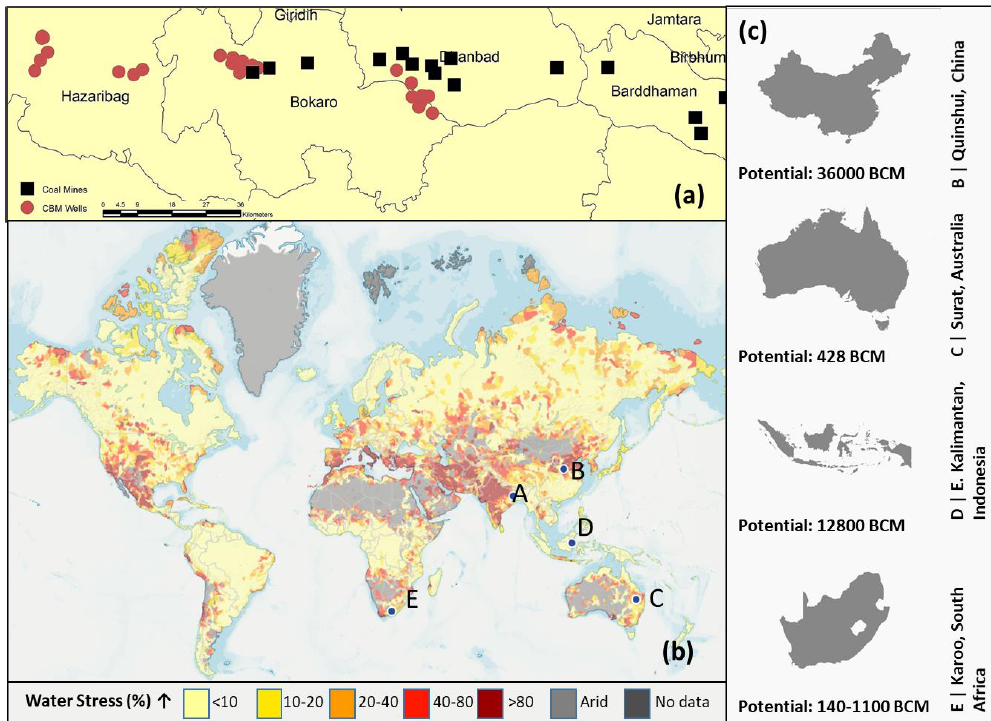
Figure 5. ( a ) Our case study region in the Damodar Valley coalfields in India shows not only the possibility of a large amount of CBM-produced waters but also that these could be integrated with the ongoing mine water treatment trials in the region [48–50]. At the same time, ( b ) the global water stress map shows high water stress in several prominent CBM basins in the Asia-Pacific [51]. ( c ) These include −50,000 BCM gas potential across several countries with active or high prospects of production indicated [5].